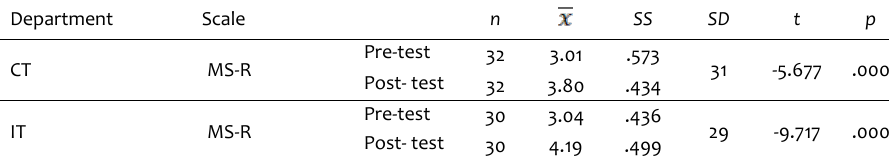
Table 5. Comparison of group pre-test and post-test scores